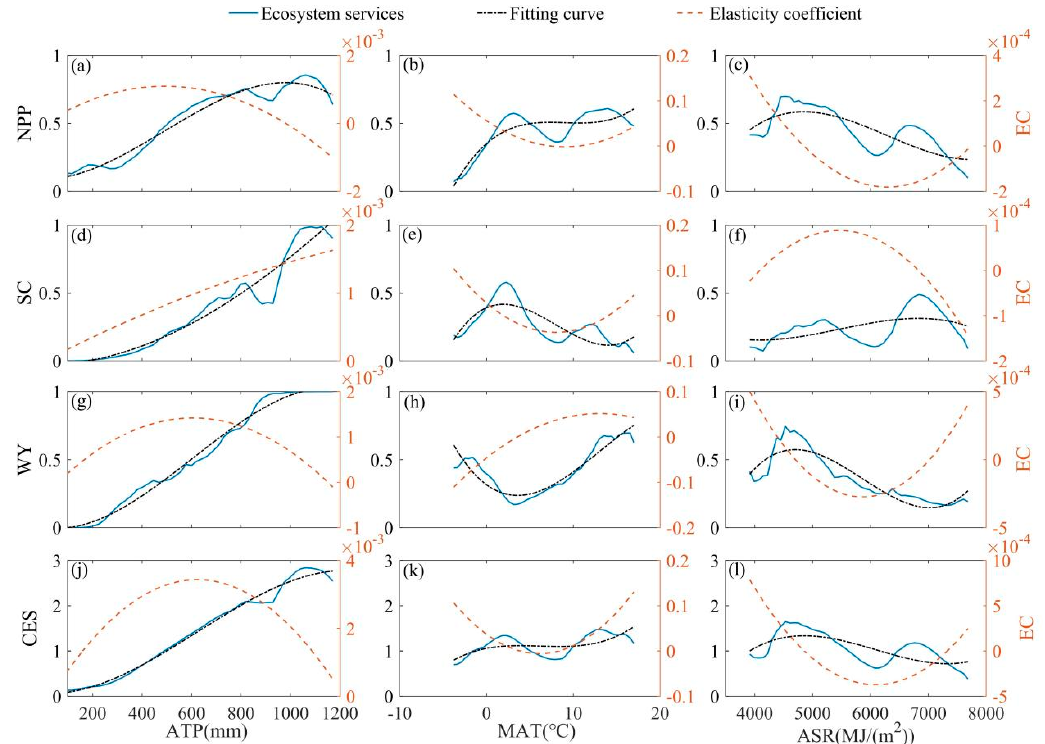
Figure 6. Changes in the ESs, the elasticity coefficient and climate factors (Note: ( a – c ) are fitted curve for NPP with climate factors; ( d – f ) are the fitted curve for SC with climate factors; ( g – i ) are the fitted curve for WY with climate factors; ( j – l ) are the fitted curve for CES with climate factors).